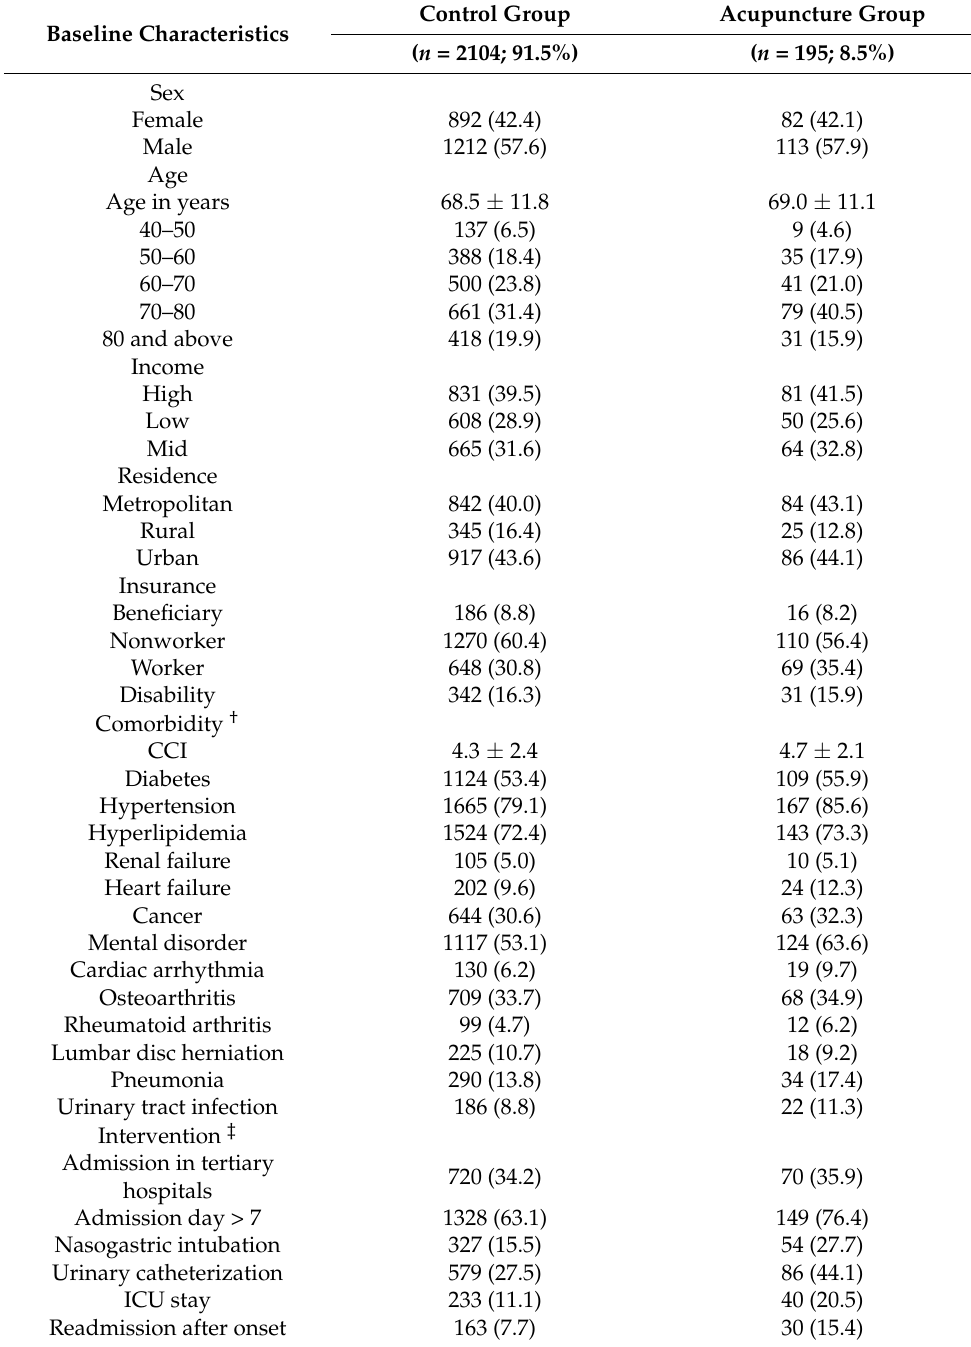
Table 1. Baseline characteristics of